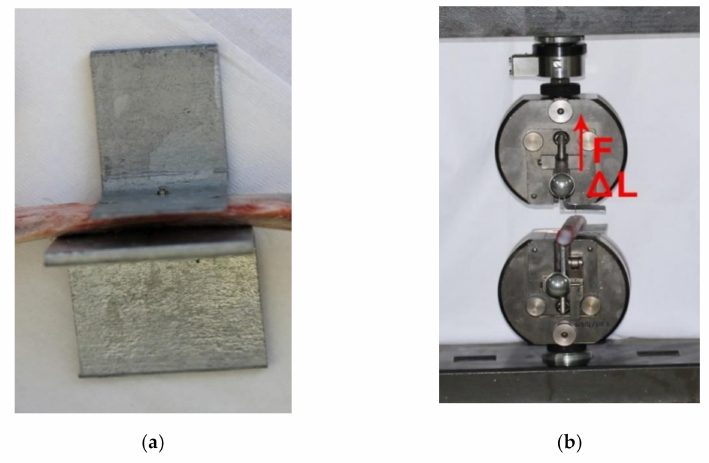
Figure 5. Sample prepared to perform the pull-out testing ( a ). Direction of force (F) and displacement ( ∆ L) at implant–bone interface ( b ).